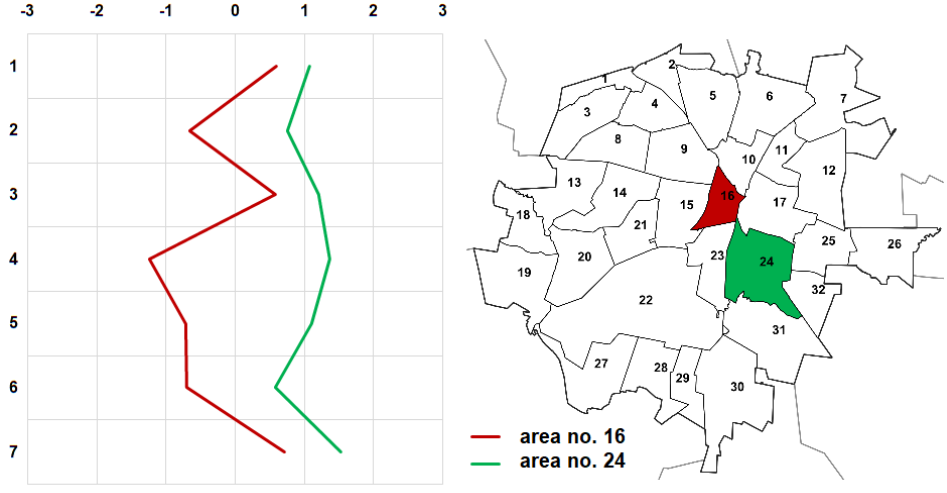
Table 6. Standard deviations of the responses given in the survey.